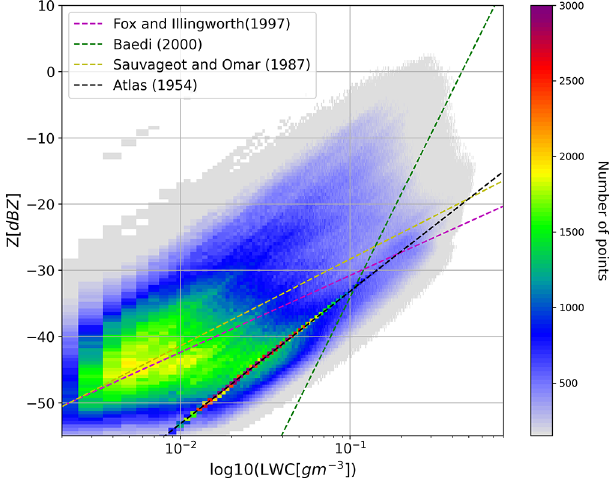
Figure 12. Retrieved LWC as a function of radar reflectivity Z for 39 cloudy days, with reference plot of various empirical relations for different cloud